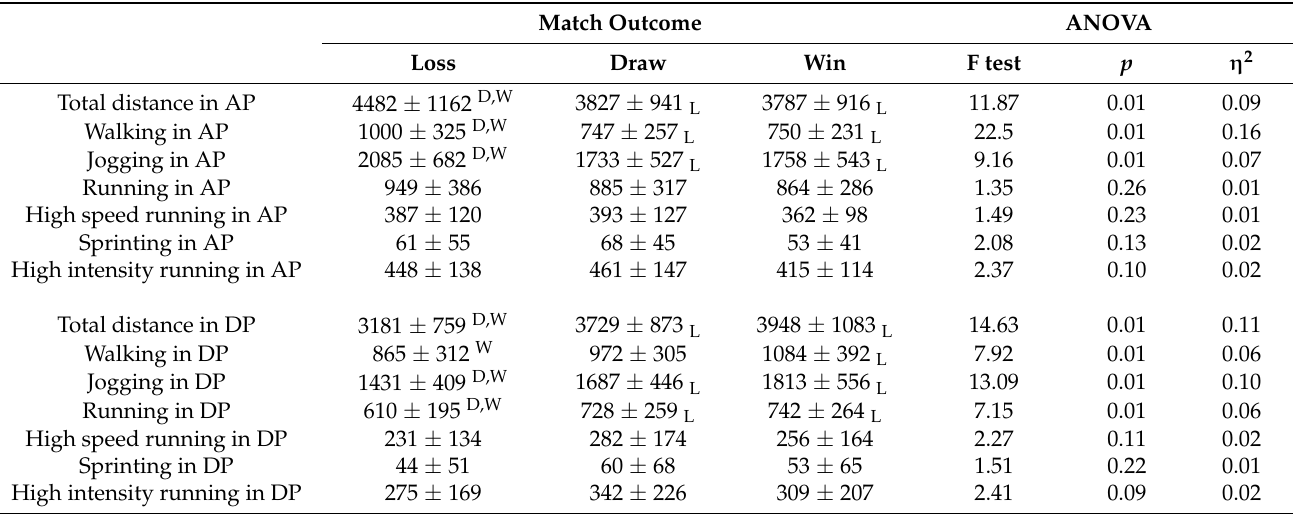
Table 4. Descriptive statistics and differences in running performances according to the match outcome (data are given as Mean ±